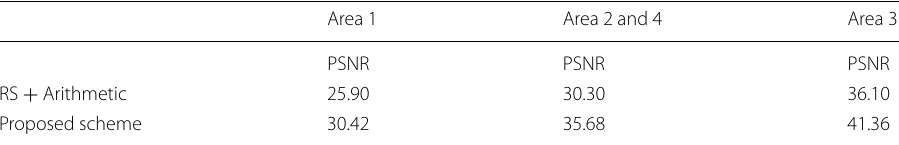
Table 8 Average performance of Barbara image in terms of PSNR